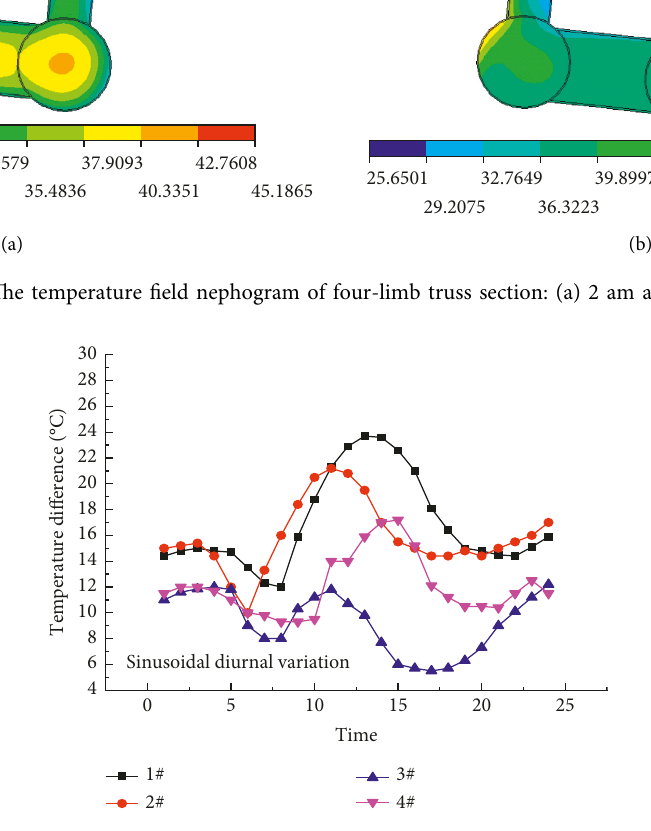
Figure 24: The daily variation of the maximum temperature